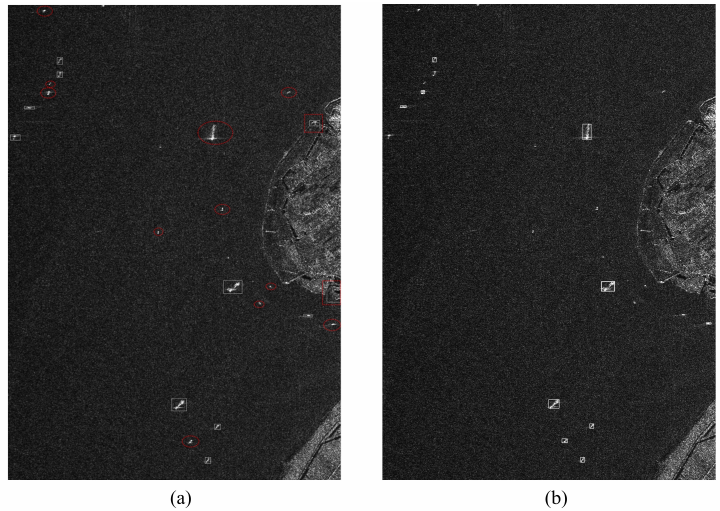
Figure 15. Results of reference algorithm. ( a ) The reference algorithm in [37]; ( b ) Deep learning network.